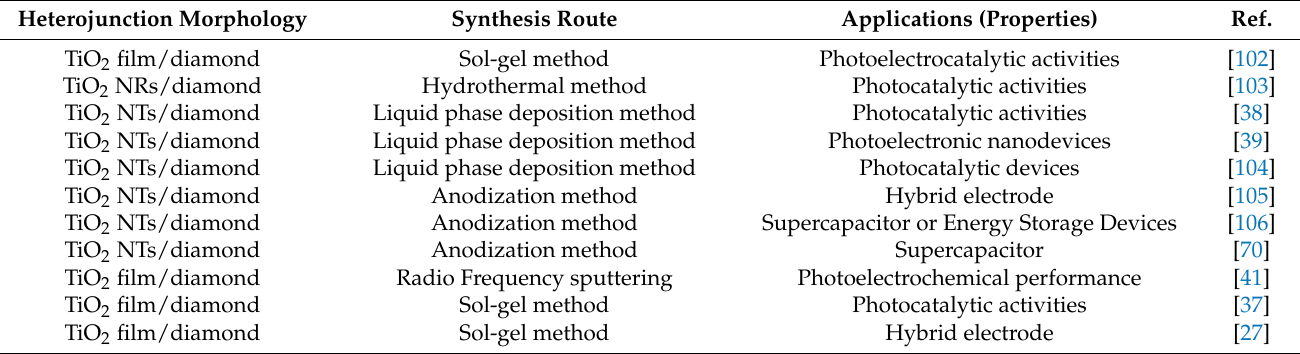
Figure 20. SEM morphology of BDD ( a ) BDD with 20 nm ( b ), 100 nm ( c ) and 500 nm ( d ), thick TiO 2 layer [41]. Table 2. Heterojunction applications and properties of 1D n-TiO 2 /p-diamond. Heterojunction Morphology Synthesis